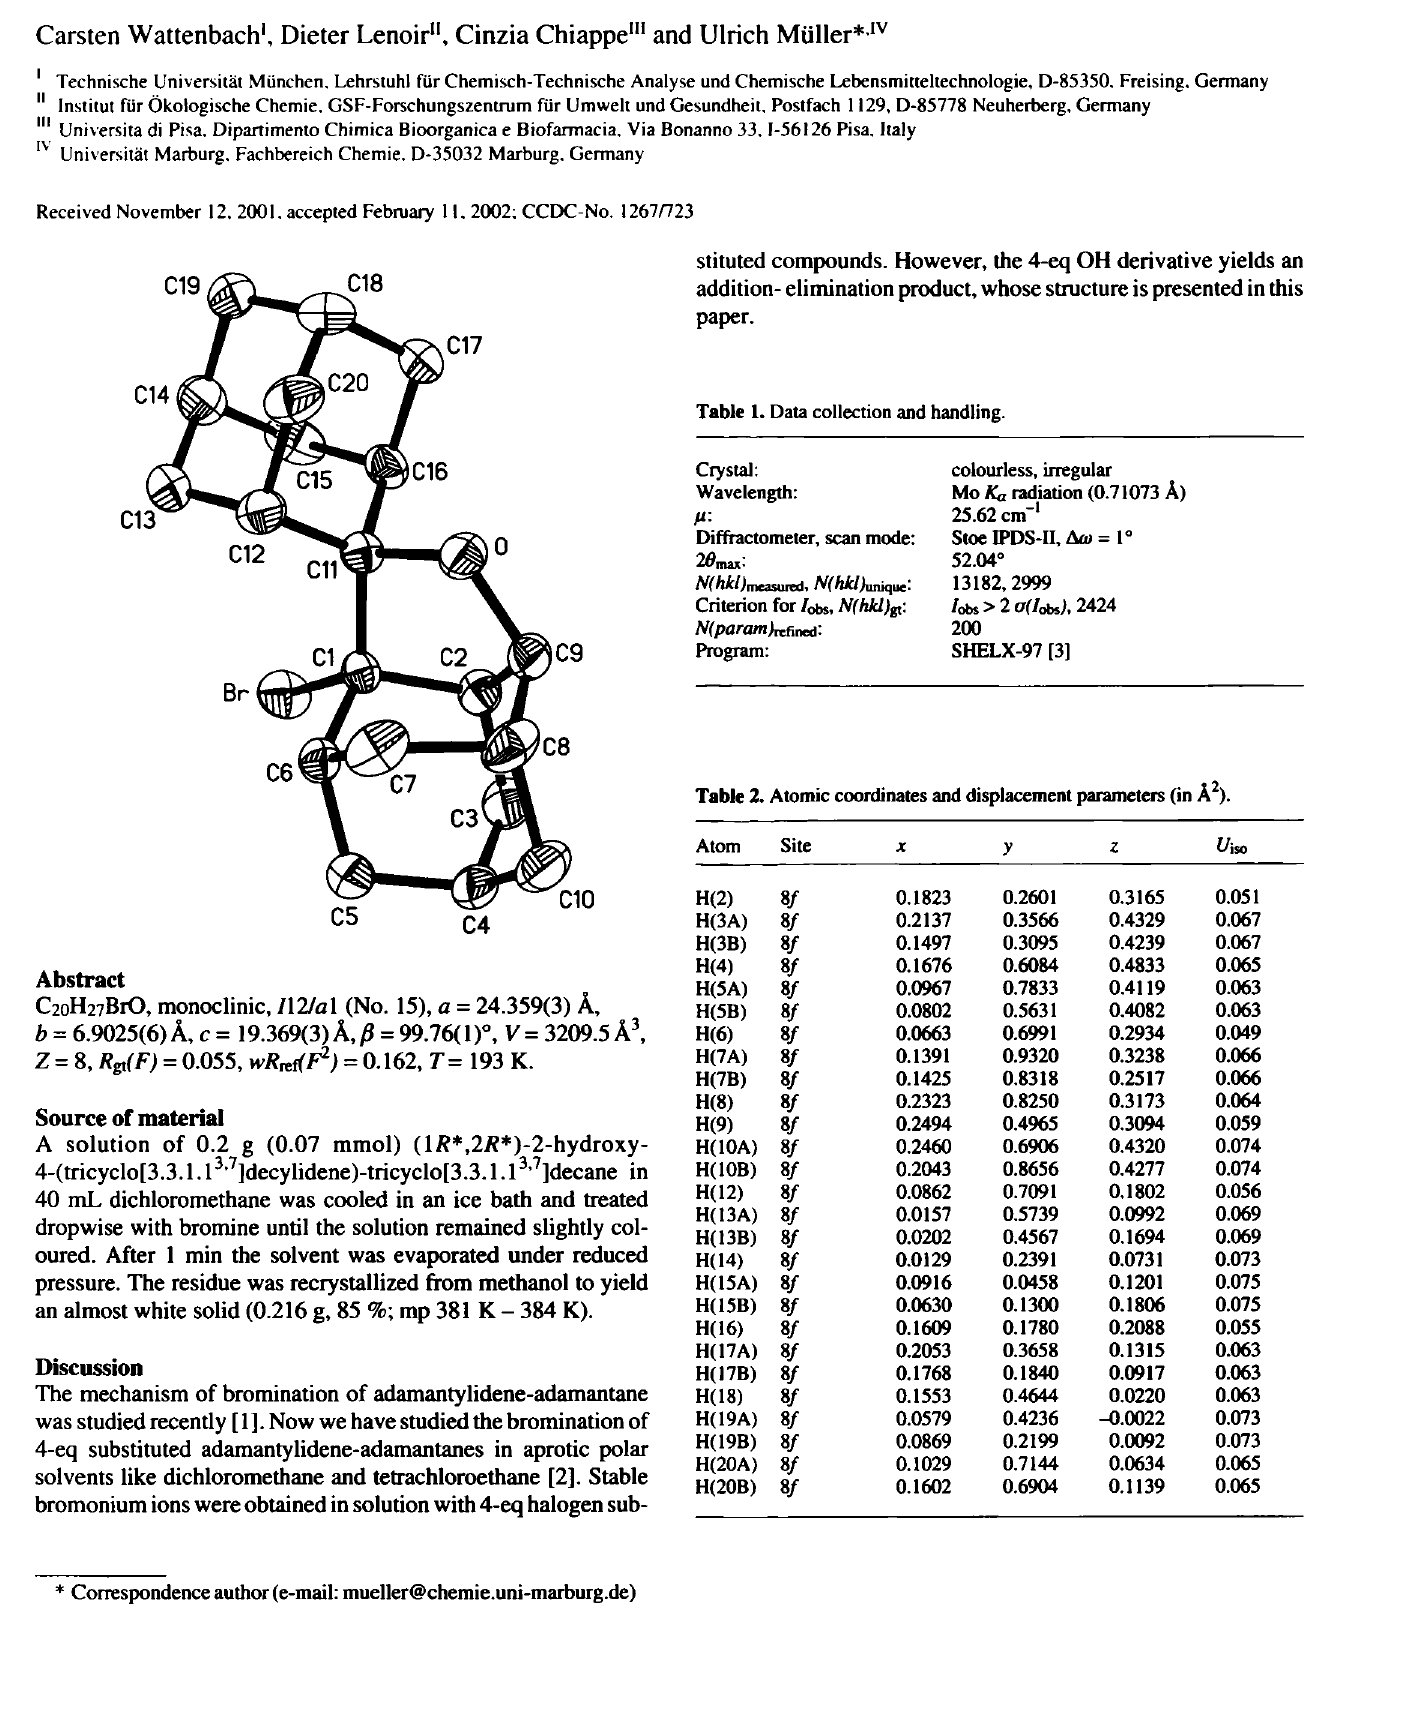
Table 2. Atomic coordinates and displacement parameters (in Â 2